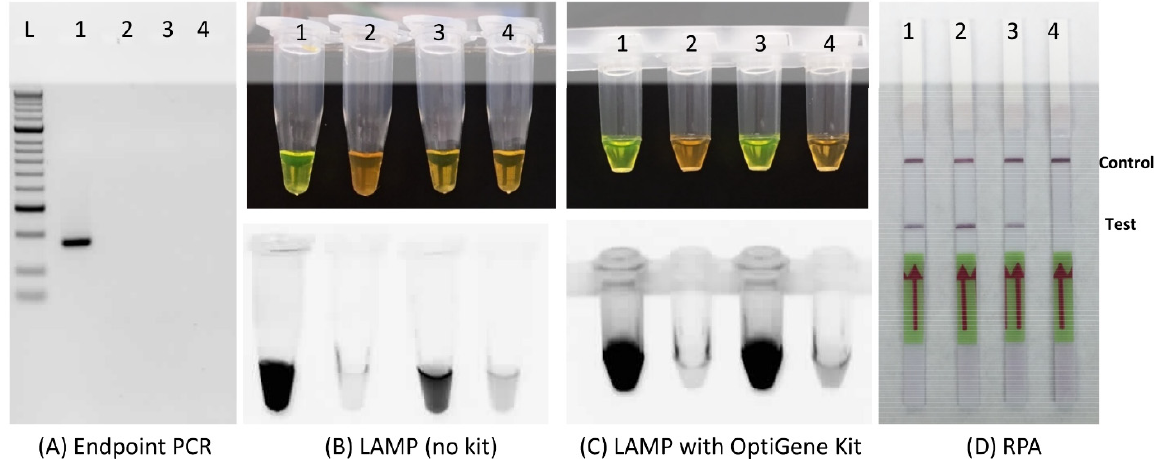
Figure 6. Effects of plant inhibitors on the detection of Rathayibacter toxicus using ( A ) endpoint PCR, ( B , C ) loop-mediated isothermal amplification (LAMP), and ( D ) recombinase polymerase amplification; detection assays based on the three technologies using four chemistries were compared. ( A – D ) Lane 1—purified R. toxicus genomic DNA; lane 2—purified R. toxicus genomic DNA plus 1 μ L of rose leaf extract; lane 3—purified R. toxicus genomic DNA plus 1 μ L of ryegrass seed extract; and lane 4—water (non-template control). ( B , C ) Upper pictures were taken in daylight with a regular camera; lower pictures were taken under UV light in a GelDoc system. The RPA assay was unaffected by either the rose tissue extract or the ryegrass seed extract whereas the endpoint PCR was inhibited by both. The LAMP assay was inhibited by